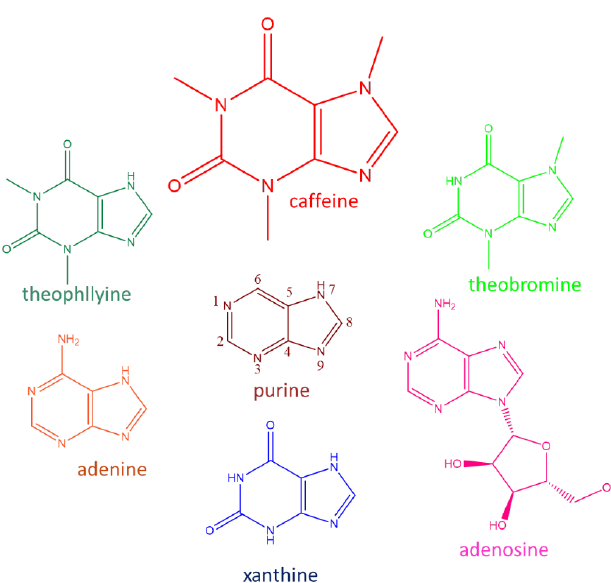
Figure 1. Chemical structures of some purines chemically related to caffeine.